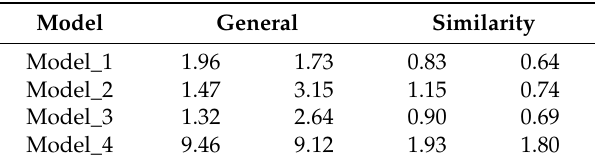
Table 4. Comparison of circle radii average pixel errors under different illuminations by robust enhancement algorithm.